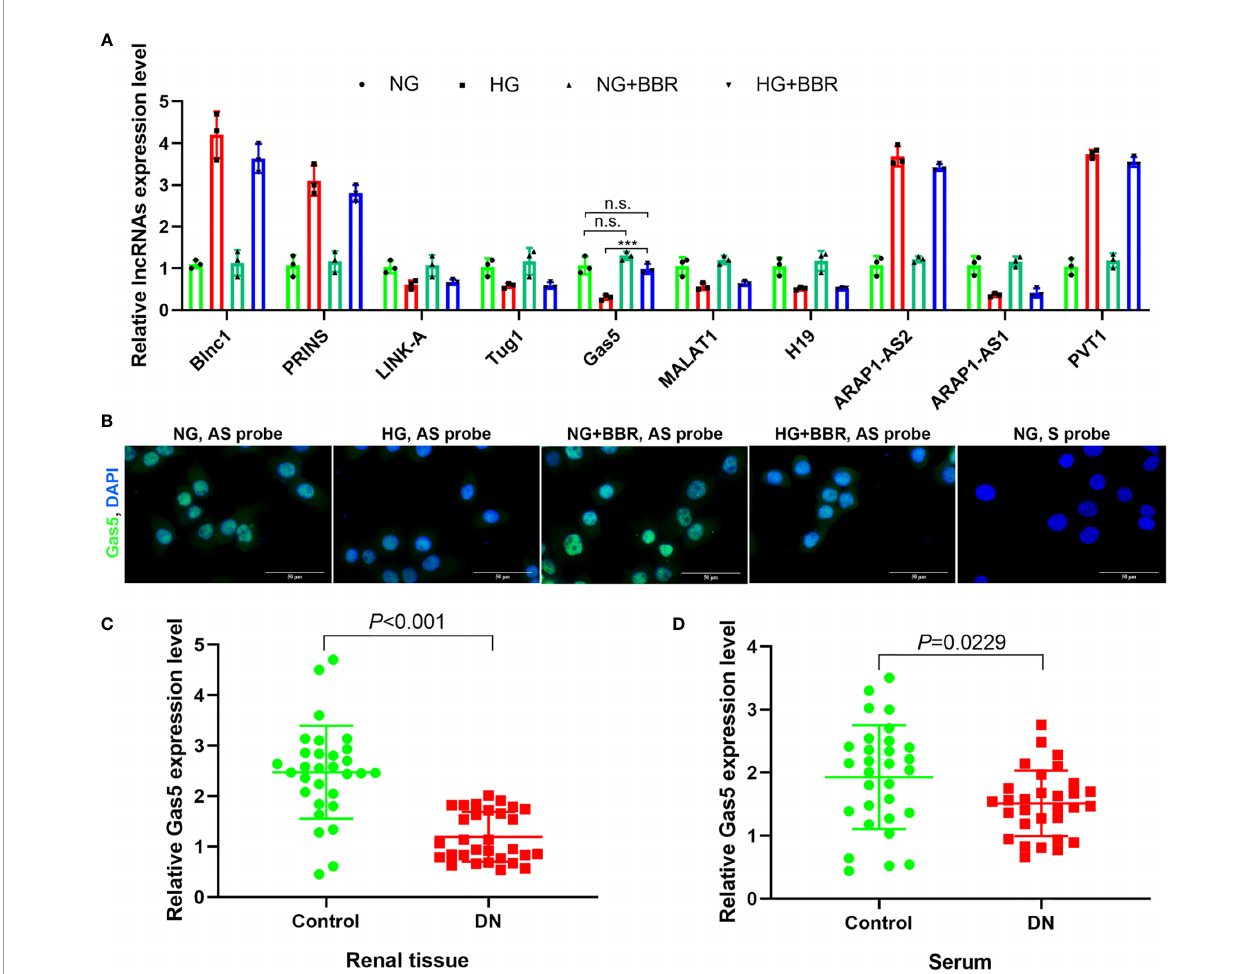
FIGURE 2 | lncRNA Gas5 may be the therapeutic target of BBR. (A) The expression level of 10 lncRNAs in different groups was analyzed by RT-PCR. (B) RNA FISH results of the HG effect on the Gas5 expression in HK-2 cells. (C) The Gas5 expression was detected in renal biopsy specimens of DN patients and paracancerous tissues of renal cancer patients by RT-PCR. (D) Gas5 expression in serum of DN patients and healthy people. *** p < 0.001. n.s., no signi fi